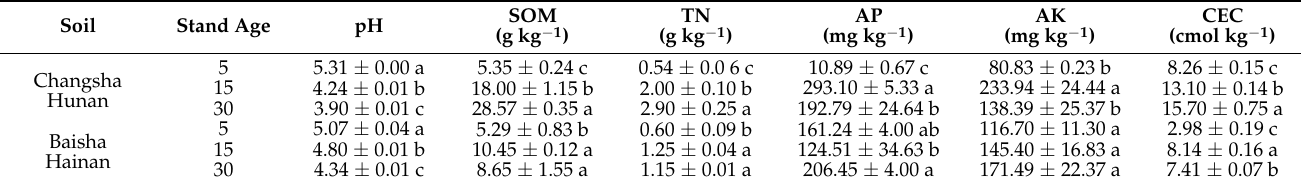
Table 1. Basic properties of tea field